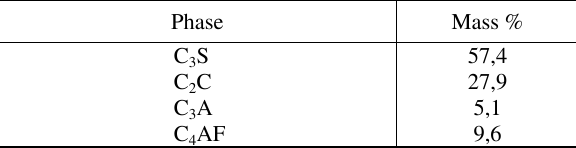
Table 1. Phase composition of Portland cement clinker